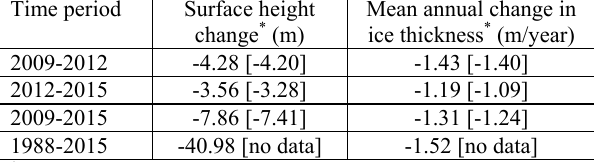
Figure 8. Estimation of equilibrium line altitude (ELA) for Gössnitzkees (longitudinal profile) for the period 1997-2009.